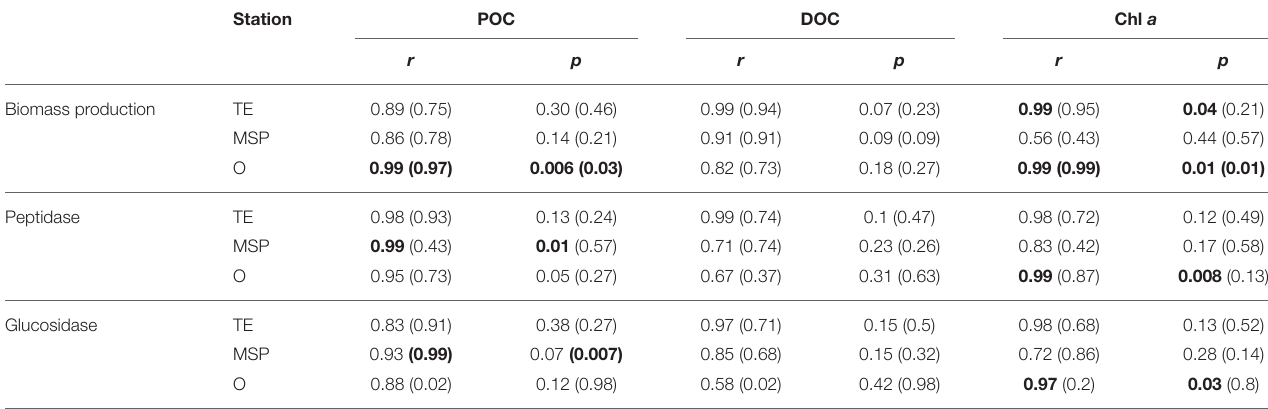
TABLE 3 | Parson’s correlation coefficient (r) between bacterial activity parameters and POC, DOC, and Chl a ( r and p -values from cell-specific activities in parenthesis). Station POC DOC Chl a p p Biomass